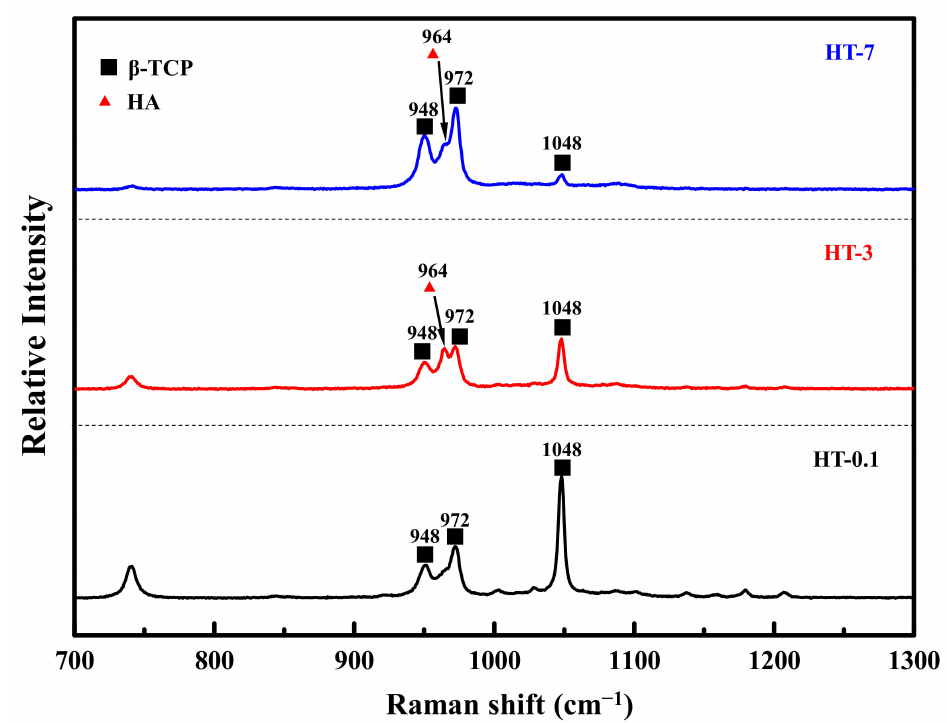
Figure 7. Raman spectra of the investigated samples prepared by the heat treatment of as-prepared coral and DCPA at different